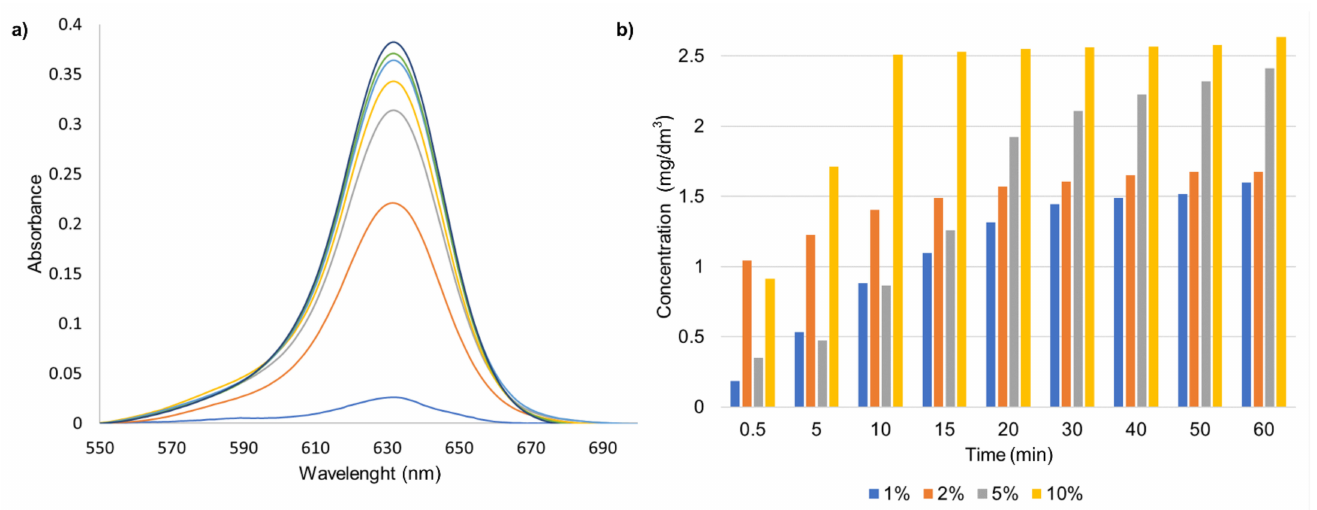
Figure 12. Release of the DMASQ dye from CS + 1% DMSQ chitosan film suspended in methanol–increase of absorption band in 1 h ( a ); changes of DMASQ concentration (mg/dm 3 ) released in time for chitosan films with 1, 2, 5, and 10% DMASQ during 1 h, calculated based on the molar absorption coefficient ε = 75,746 M − 1 · cm − 1 ( b